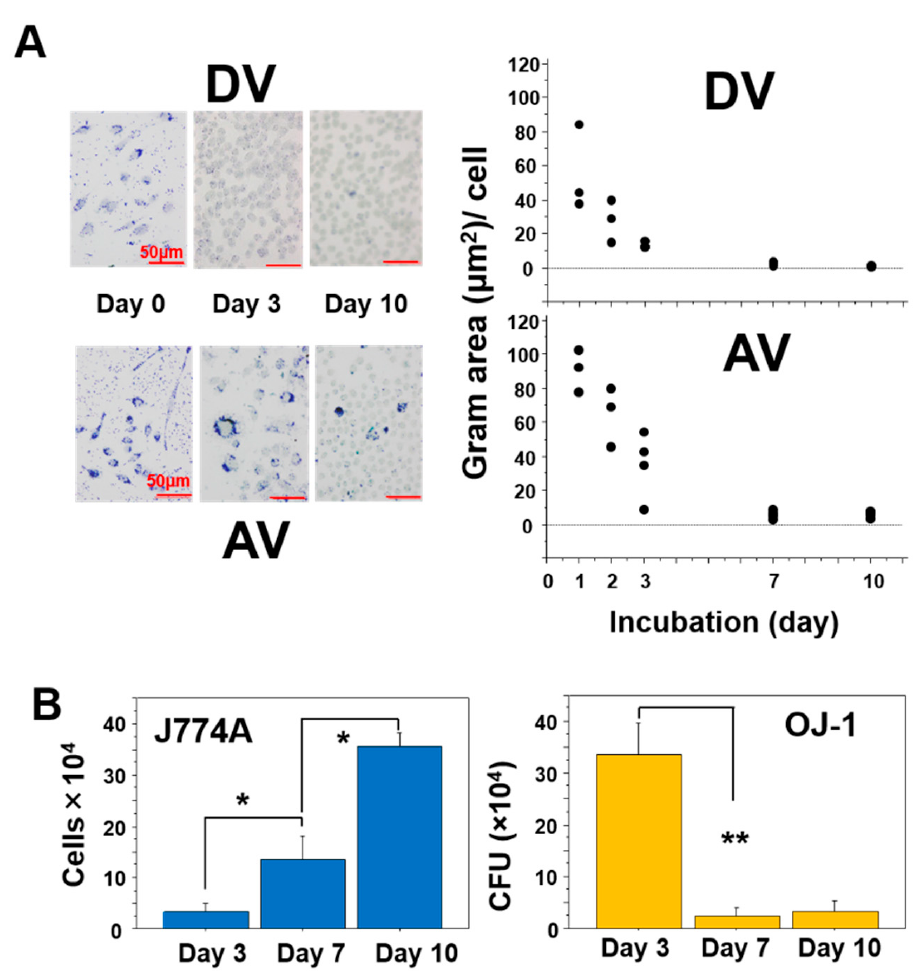
Figure 3. Intracellular distribution of OJ-1 in J774A cells. After ingesting the same number of OJ-1 in the dead (DV group) or in the alive (AV group), intracellular bacteria stained with Gram stain were morphometrically measured. ( A ) Time courses of Gram-stained area per cell in the DV and AV groups. ( B ) Number of J774A cells per well and total bacterial CFU number per well, and the calculated CFU per cell on days 3, 7, and 10. Data: mean ± S.D. *: p < 0.05. **: p < 0.01.